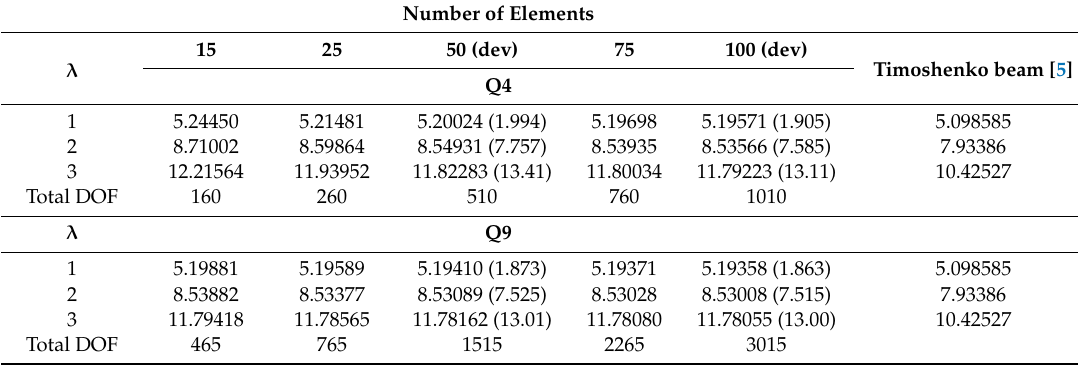
Table 4. Convergence analysis using the bi-linear element Q4 and the bi-quadratic element Q9. Number of